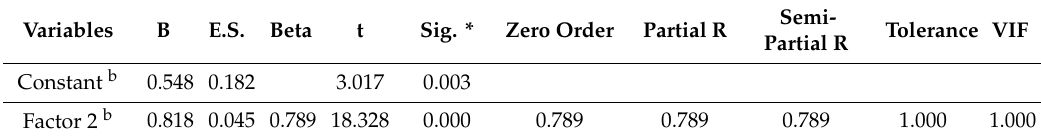
Table 11. Linear regression of the development of mathematical thinking a,c in early childhood education with the use of video games for